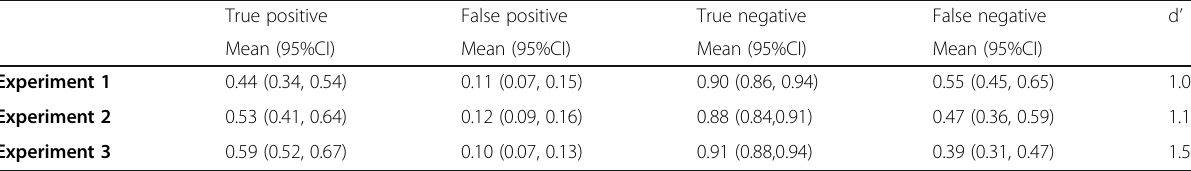
Table 1 Proportion of responses for the N-back task across Experiments 1 – 3